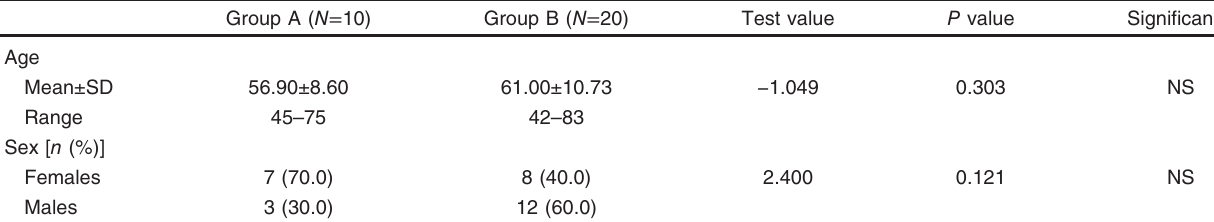
Table 3 Age and sex for group A and group B